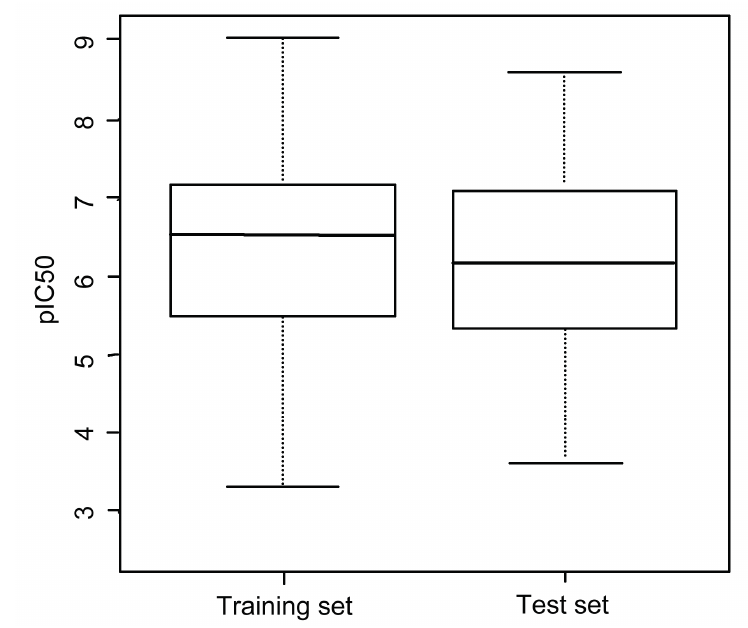
Figure 7. Biological activity range of training set and test set.